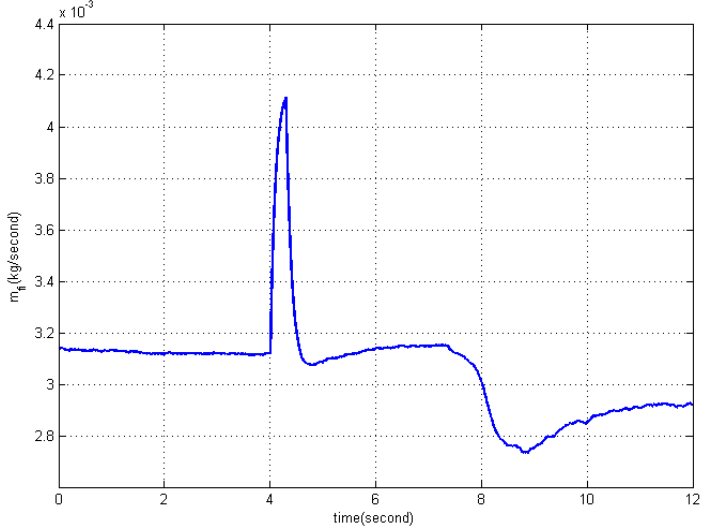
Figure 11. Fuel injection rate after a sensor fault occurs.